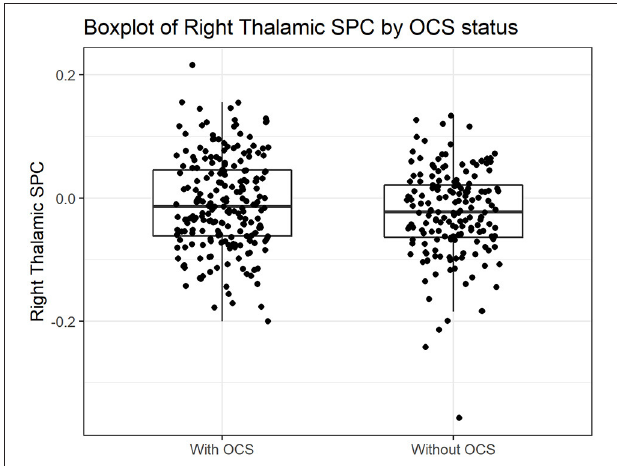
FIGURE 2 | Boxplot of Right Thalamic SPC in participants with and without obsessive-compulsive symptoms at follow-up. SPC, Symmetrized Percent